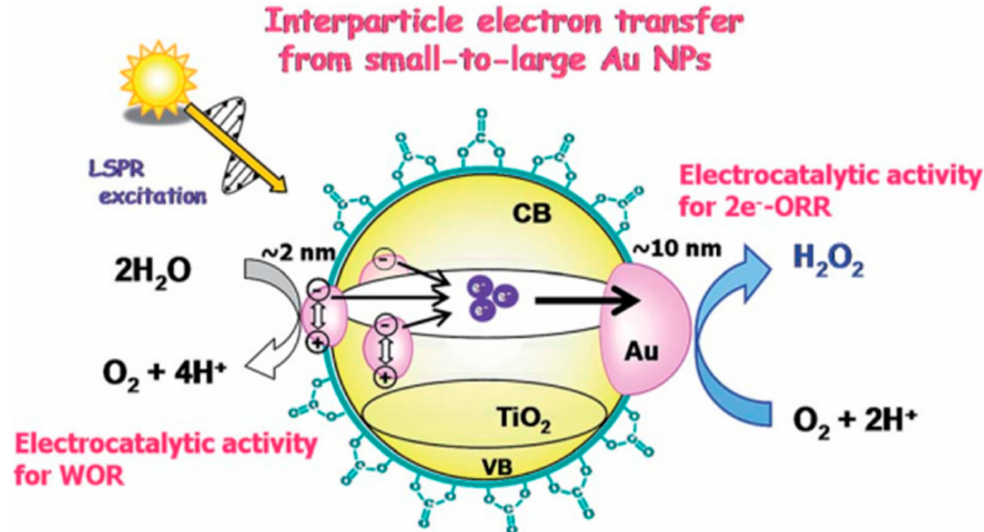
Figure 58. A schematic representation of H 2 O 2 from water and O 2 by the BM-Au/TiO 2 plasmonic photocatalyst. Repro- duced with permission from Nano scale Adv. [455], Copyright 2019,